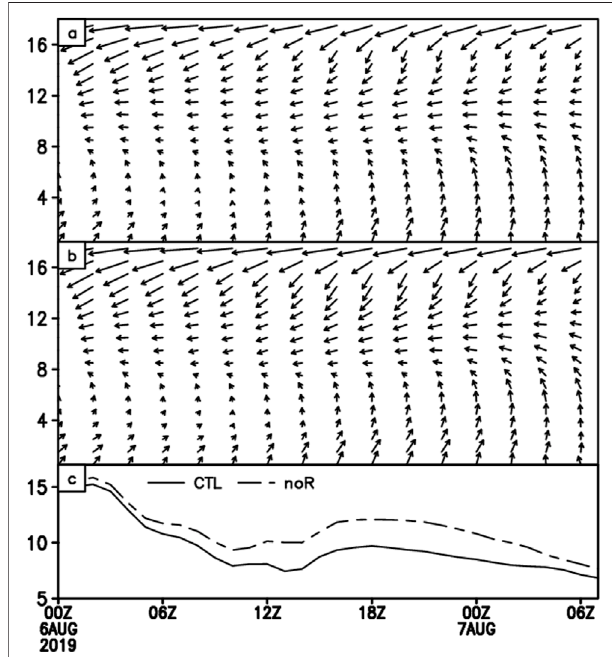
FIGURE 10 | The time evolution of the vertical pro fi les of the steering fl ows (units: m s − 1 ) in (A) CTL, (B) noR, and (C) the total wind speed for the vertical wind shear (16 – 2 km height; units: m s − 1 ) from 6 to 7 August.